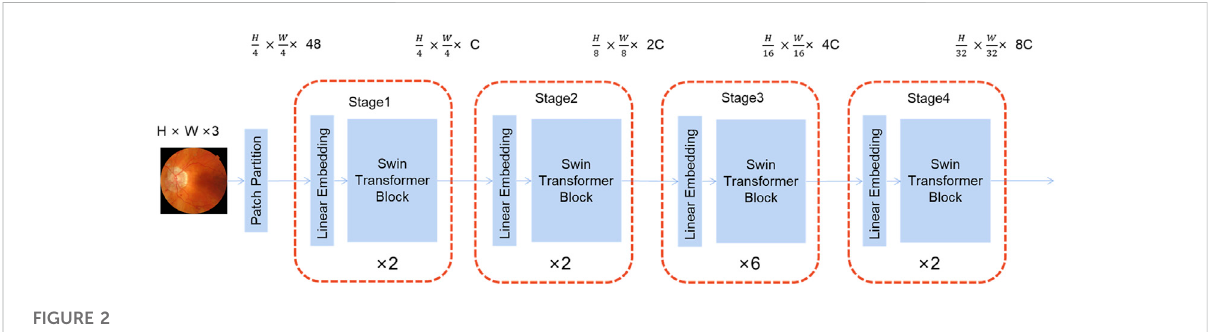
FIGURE 2 The framework of the Swin transformer.